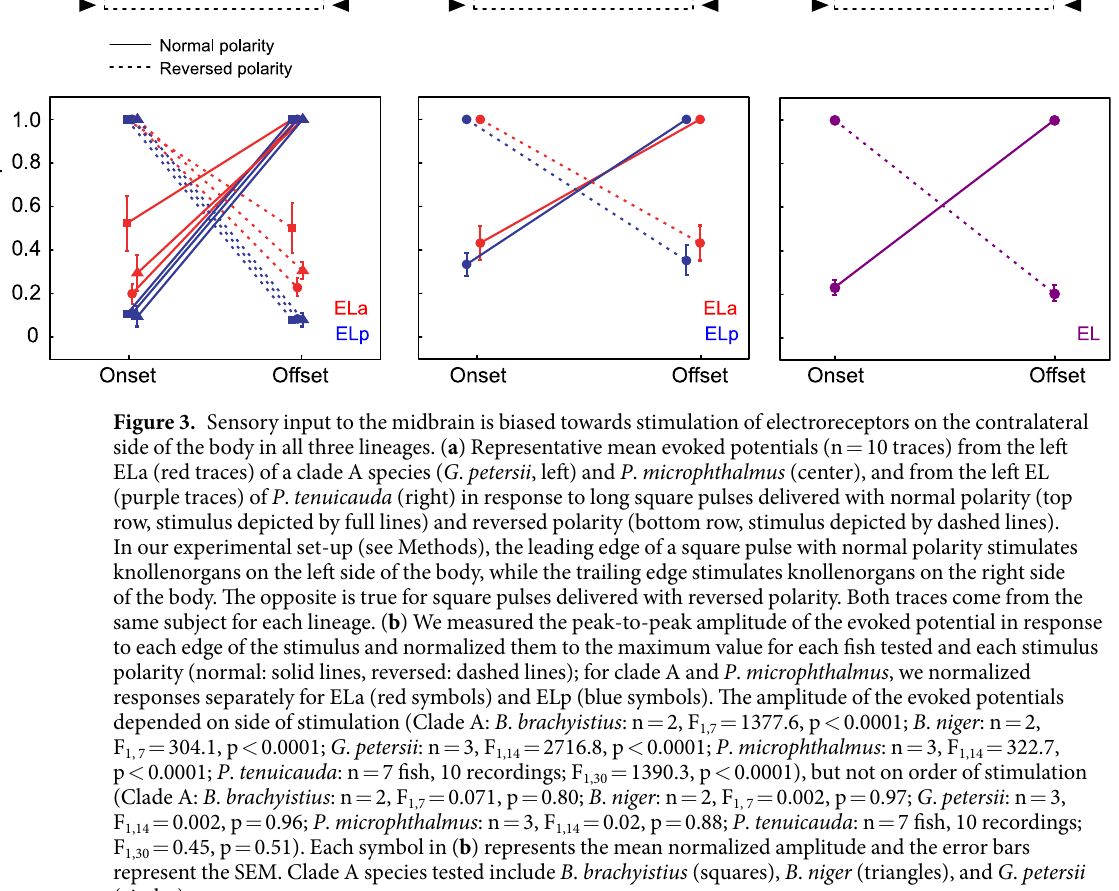
3 = 3.84–6.22, n = 145). These cells were smaller than GABAergic cells in ELa and ELp (Fig. 4c) and similar in size to the small cells previously described in clade-A species 28, 29, 34, 37 . In P . tenuicauda , iontophoretic injections of neuronal tract tracers into the anterior end of EL labeled axonal projections into the posterior end of EL (Fig. 2a). Neuronal tract tracers injected into the posterior end of EL revealed multipolar cells throughout EL and adendritic cells toward the anterior end of EL and in the lateral lem- niscus (Fig. 4b). The sizes of labeled adendritic cells in P . tenuicauda (Non-outlier ranges of stained cell diameters in µ m: subject 1 = 3.76–6.35, n = 63; subject 2 = 3.43–7.77, n = 156; subject 3 = 4.10–10.05, n = 204) were similar to those found in ELa of clade-A species and P . microphthalmus and tended to be smaller than the GABAergic cells (Fig. 4c).